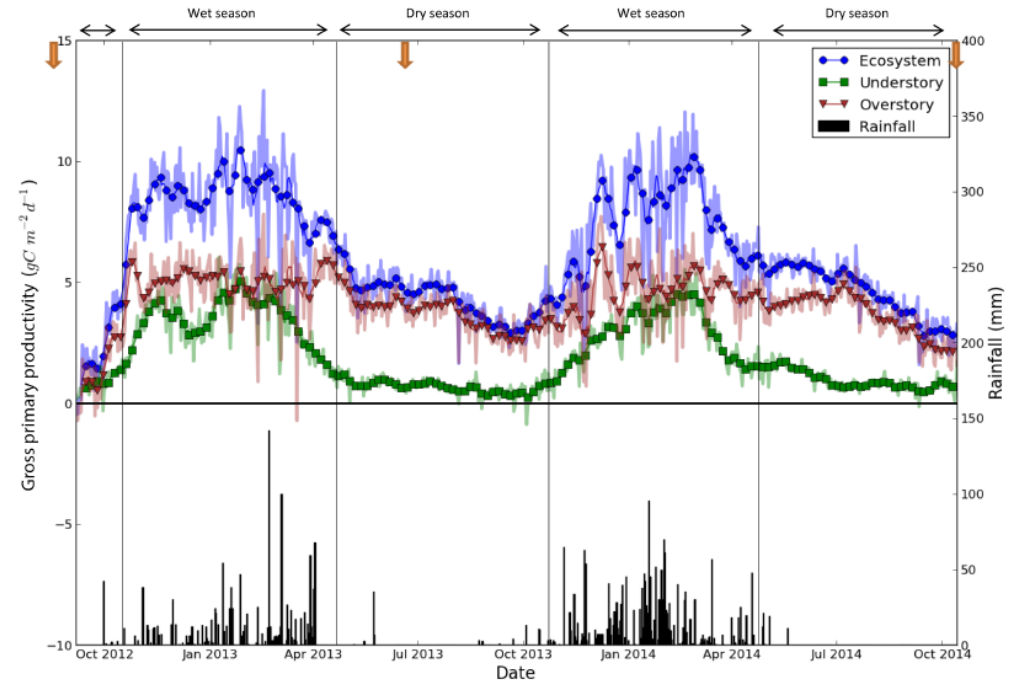
Figure 6. Smoothed (10-day running mean) time series of understorey (red), overstorey (green) and total ecosystem (red) gross primary productivity (GPP) for a mesic savanna site in northern Australia. Rainfall is represented as black bars. Negative and positive signs represent the savanna state as a carbon source or sink respectively, and orange arrows depict the occurrence of fire events. Data products for total ecosystem and understorey GPP are inferred from observations of net ecosystem exchange using eddy-covariance towers at heights of 23 and 5m respectively. Overstorey GPP is determined as the difference between the ecosystem and the understorey. Reprinted with permission from Moore et al.